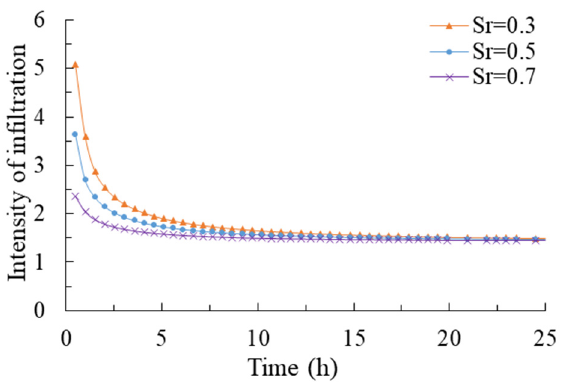
Figure 13. Time series for the intensity of infiltration at different saturation degrees.